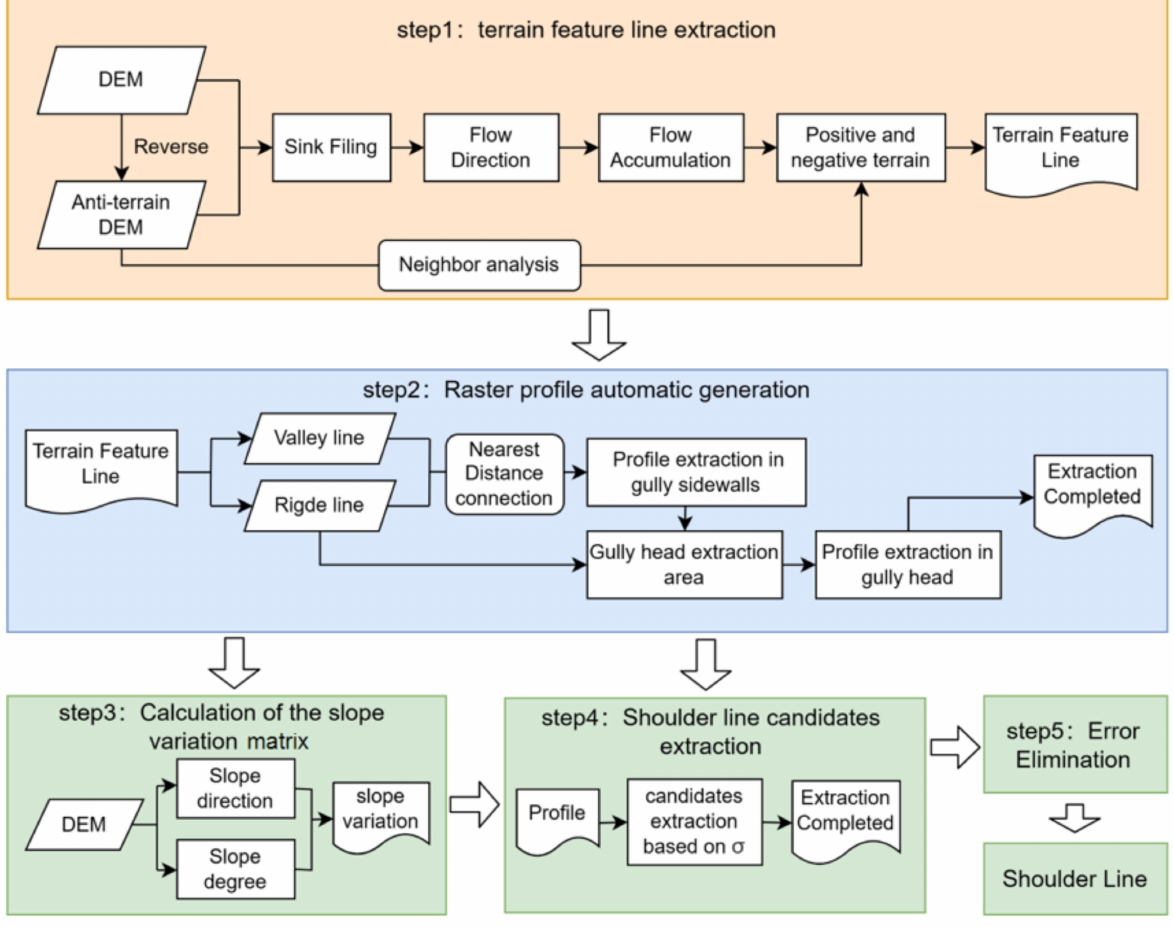
Figure 5. Automatic shoulder line extraction flow